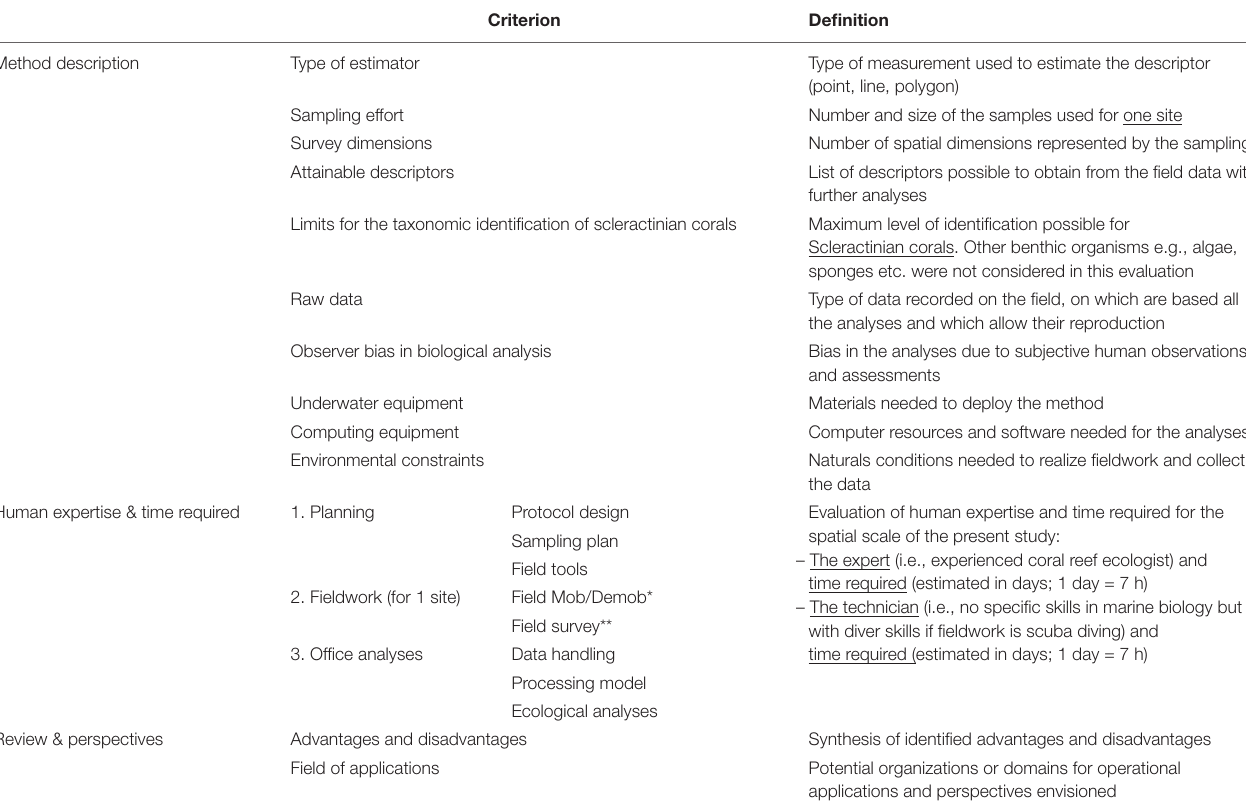
TABLE 1 | Definition of each criterion used for the description and comparison of survey